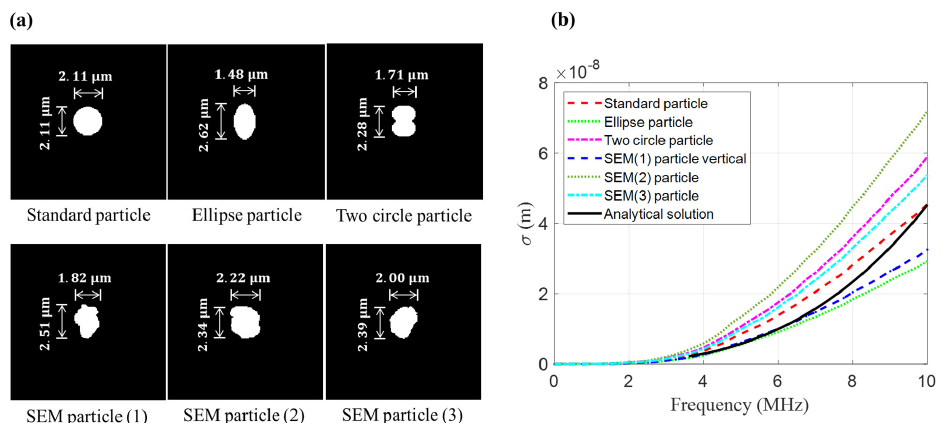
Figure 9. Variations of scattering cross-section under varying scatterer shapes: ( a ) six different particle shapes and ( b ) their corresponding total scattering cross-sections.